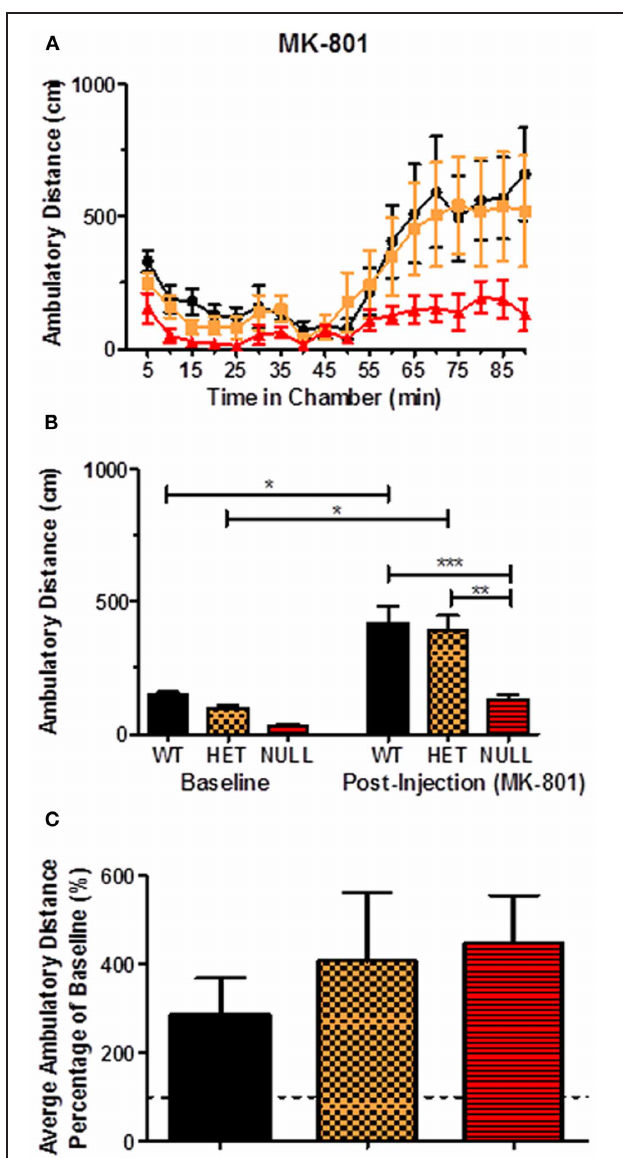
FIGURE 9 | Locomotor response to acute SKF83959. SKF83959 (1mg/kg; i.p.), a dopamine D 1 receptor agonist that has been reported to activate D 1 receptors coupled to G α q , significantly increases locomotor activity in G α q knockout, heterozygous, and wildtype mice ( A,B ; F ( 5 , 18 ) = 123 . 9, p < 0 . 001). There is also a significant difference in the post-injection locomotor response of the null mice compared to their wildtype and heterozygous littermates ( B ; F ( 5 , 18 ) = 123 . 9, p < 0 . 001) and a significant difference in the percentage change from baseline of the knockouts [ C ; F ( 2 , 33 ) = 7 . 0, p < 0 . 05] and heterozygotes [ F ( 2 , 33 ) = 7 . 0, p < 0 . 001] compared to wildtype. n = 12–18 for each genotype.